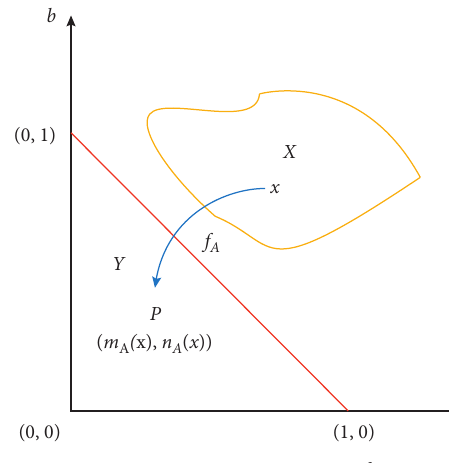
Figure 1: Geometric meaning of